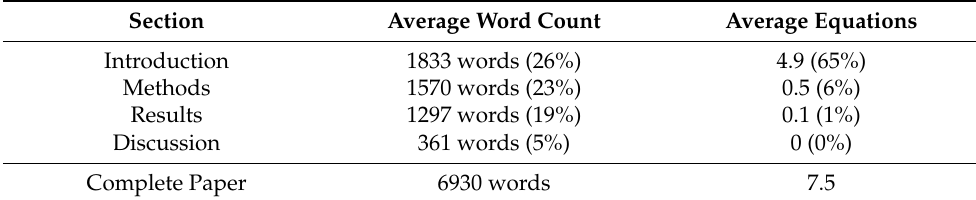
Table 5. Average word counts and average numbers of equations per article section.